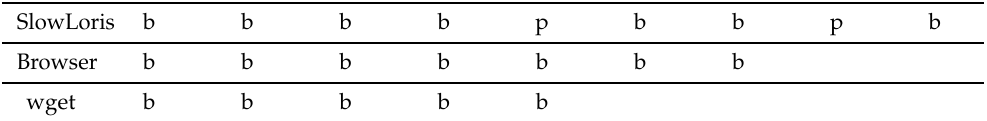
Table 5. Browser vs.